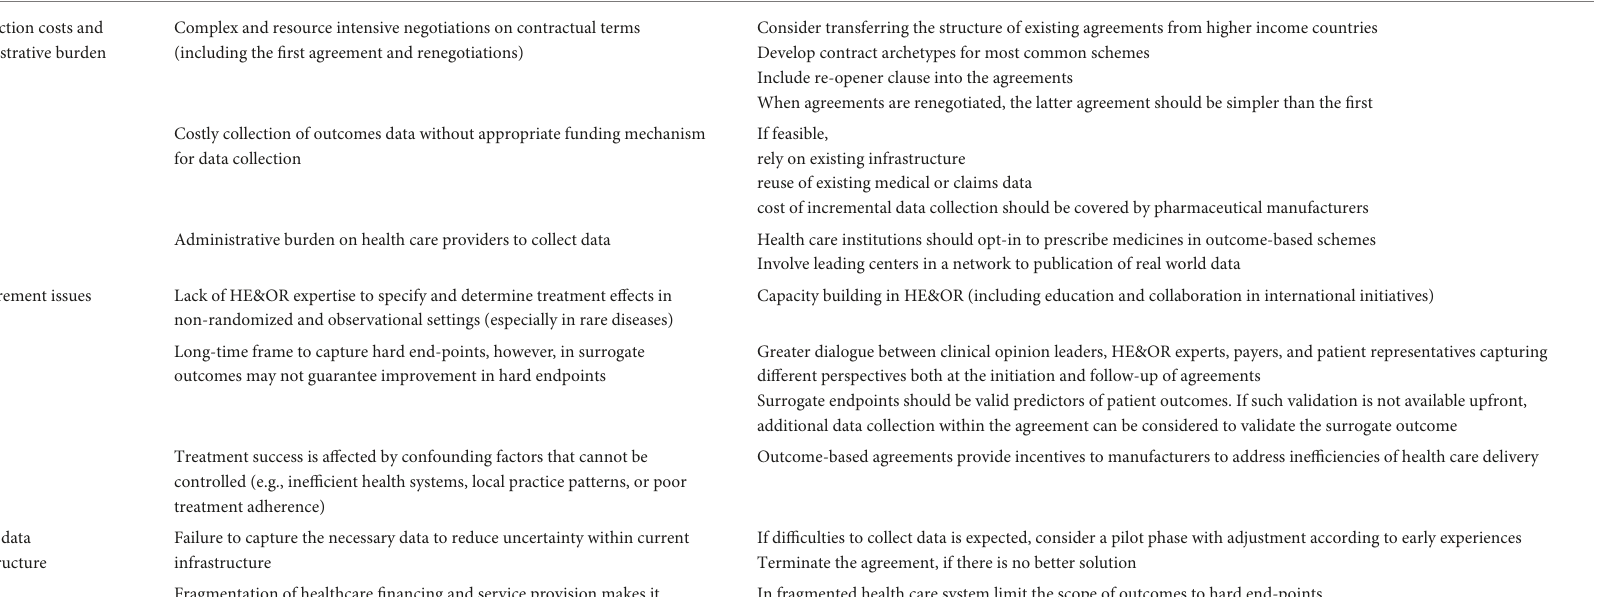
TABLE 1 Summary of barriers and recommendations for health care payers for the implementation of outcome-based reimbursement models. Group of